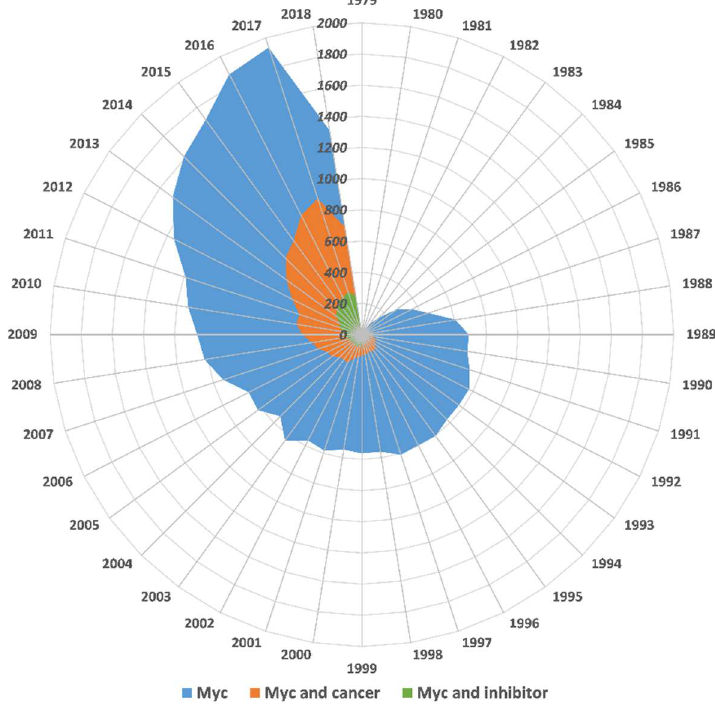
Figure 1. 40 years of Myc research. Increase in the number of publications available in NCBI PubMed on Myc in general (blue), Myc in cancer (orange), and Myc inhibition (green) from 1979 to 2018.